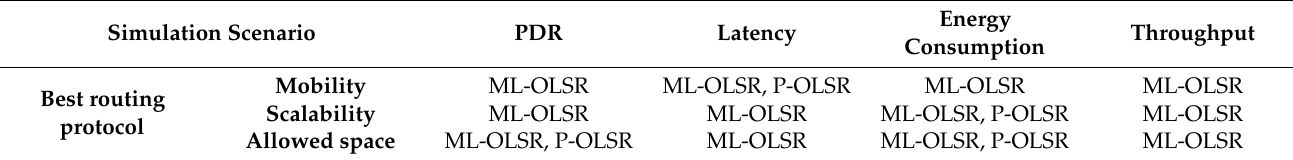
Table 5. Summary of the OLSR-based routing protocols based on the three simulation scenarios and performance metrics.